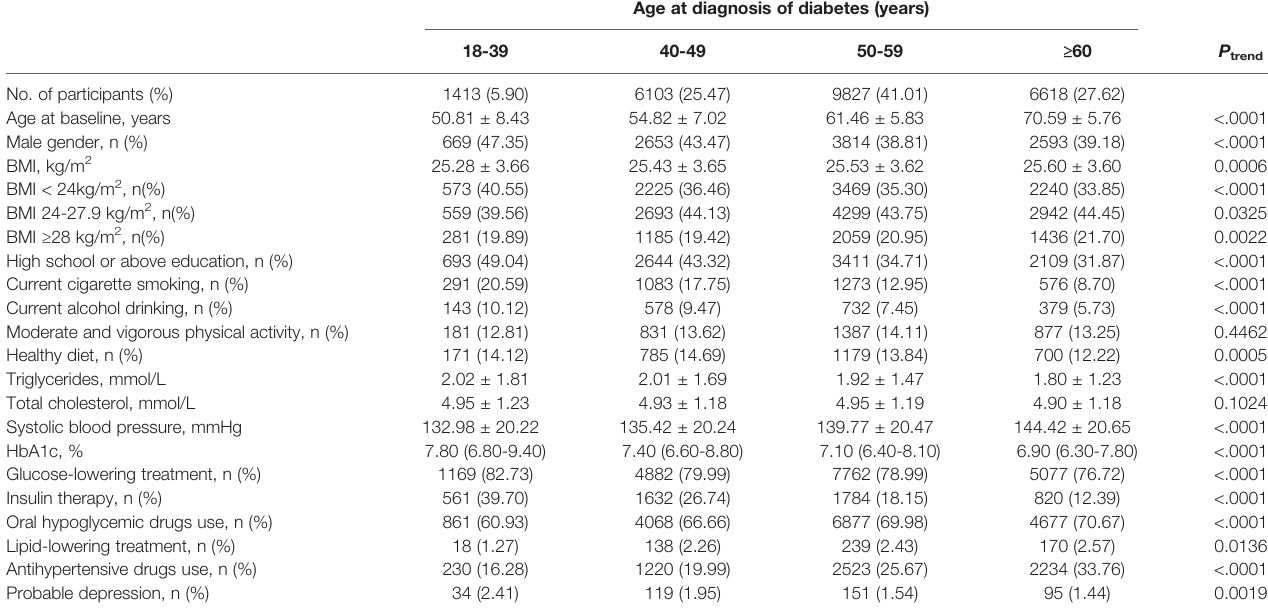
TABLE 1 | Baseline characteristics according to age at diagnosis of